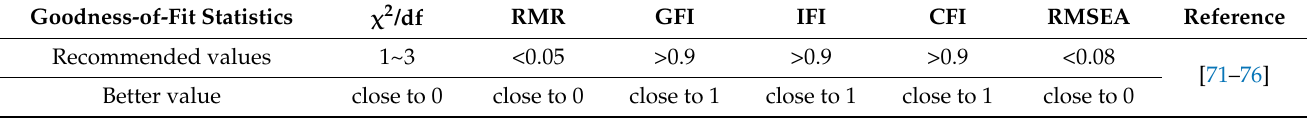
Table 7. Overall goodness-of-fit statistics of the confirmatory factor analysis performed.